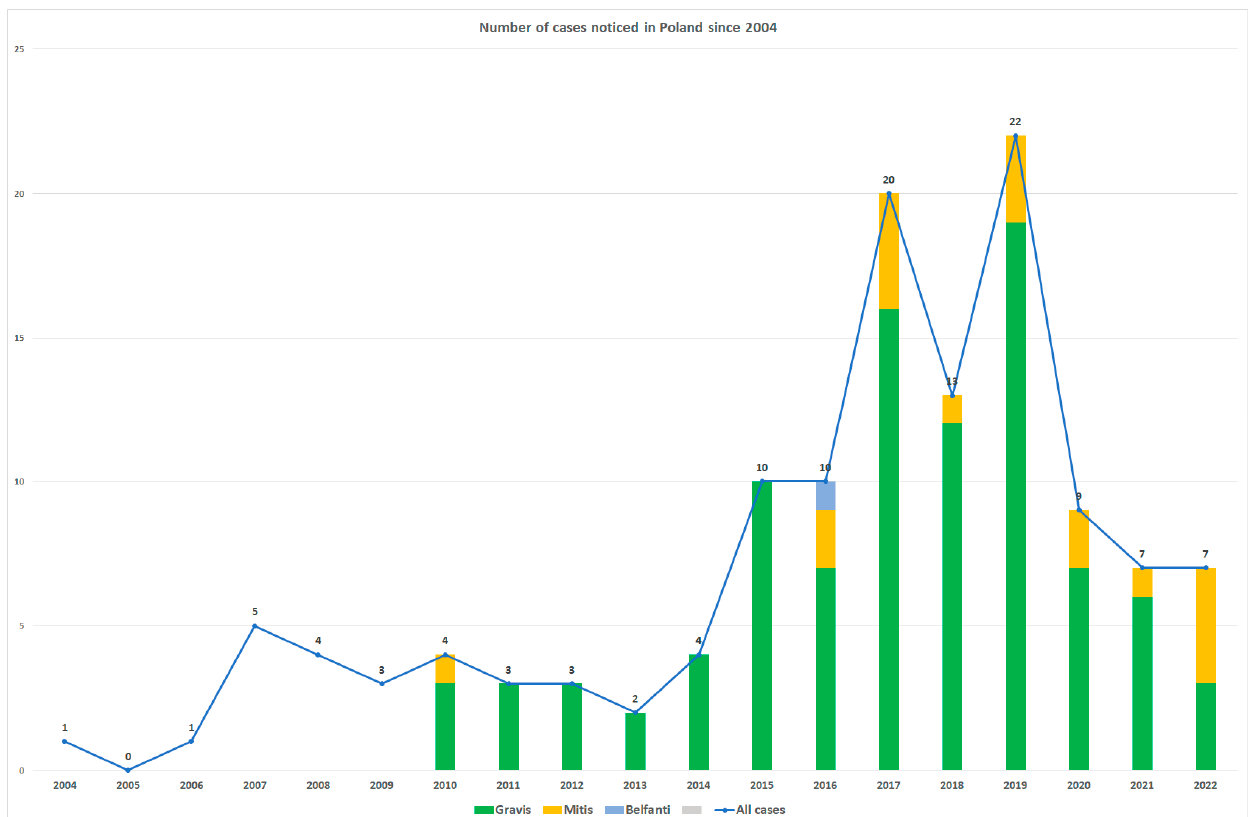
Figure 2. The number of C. diphtheriae infections recorded in Poland since 2004. The non-toxigenic gravis strains from ST8 are predominant in Poland and their recorded number has been stable over the years. Between 2011 and 2015, only C. diphtheriae strains from this biovar were isolated in Poland. Since 2016, the mitis biotype strains have also been observed every year but at a much lower number (one to four cases per year), while before 2022, all these mitis strains belonged to ST439. Therefore, the picture of the C. diphtheriae strains isolated in Poland before 2022 looks rather monotonous and it was limited to only two biovars and two sequence types. These data correspond to a previous analysis performed by Czajka et al. [12], where the non-toxigenic gravis ST8 strains were also definitely the most frequently observed. This suggests these strains can be endemic to Poland. In contrast, in neighboring Germany, 20 different STs were identified among 76 strains from 2016 to 2017, but the most commonly identified were also ST8 (54%) and ST439 (7%), as well as ST130, which has not been observed in Poland (13%) [3]. Interestingly, ST8 C. diphtheriae was not recorded in Germany until 2015. In a comparable period of time, in Austria, around four to eight cases of Corynebacterium infections were observed every year (a maximum of thirteen cases in 2014), but the strains were much more diverse (mostly the belfanti, mitis, and gravis biovars) [13]. An additional MLST analysis of the Austrian strains confirmed this high diversity (34 different STs among 57 strains were identified) with no ST8 and only four ST439 strains. An analysis performed on the other side of Poland, in neighboring Belarus, showed that ST5 and ST8 C. diphtheriae were most frequently recorded [14]. Furthermore, in this study, ST5 included strains assigned to the belfanti, gravis, and mitis biovars and were non- toxigenic, whereas ST8 strains were toxigenic. Previously, such toxigenic ST8 C. diphtheriae strains were often isolated during the epidemic in the 1990s in the former Soviet Union (FSU) and were still isolated both in Belarus and Russia in the post-epidemic period [14,15]. Moreover, Borisova et al. [15] showed that, in Russia, most of the toxigenic strains